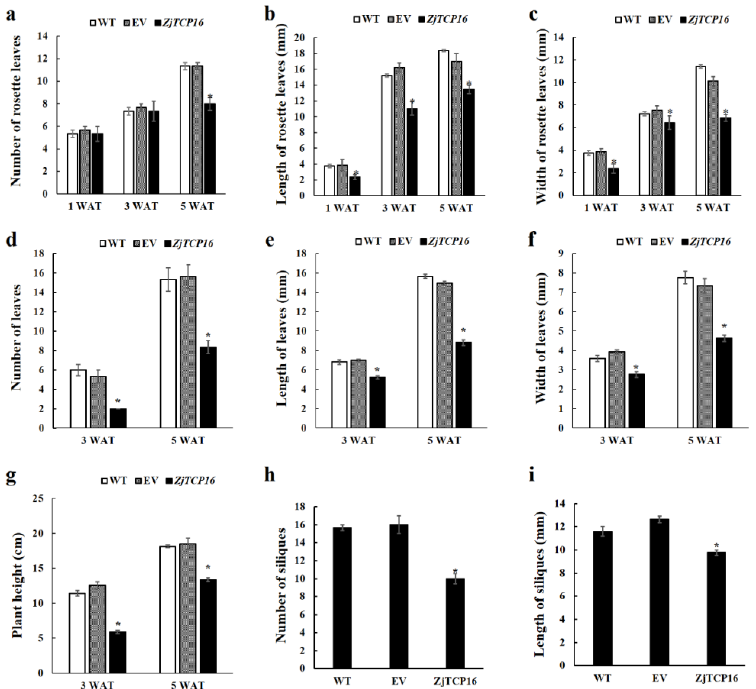
Figure 4. Growth indices of the Arabidopsis overexpressing ZjTCP16 . Bars represent the mean ± standard deviation of 9 plants. Asterisks indicated with WT (* = p < 0.05; one-way analysis of variance (ANOVA)) showed significant differences. ( a ): Average of rosette leaves number of WT, EV and ZjTCP16 -OE Arabidopsis lines. ( b ): Average length of rosette leaves of WT, EV and ZjTCP16 -OE Arabidopsis lines. ( c ): Average width of rosette leaves of WT, EV and ZjTCP16 -OE Arabidopsis lines. ( d ): Average number of leaves of WT, EV and ZjTCP16 -OE Arabidopsis lines. ( e ): Average length of leaves of WT, EV and ZjTCP16 -OE Arabidopsis lines. ( f ): Average width of leaves of WT, EV and ZjTCP16 -OE Arabidopsis lines. ( g ): Average plant height of WT, EV and ZjTCP16 -OE Arabidopsis lines. ( h ): Average number of siliques of WT, EV and ZjTCP16 -OE Arabidopsis lines. ( i ): Average length of siliques of WT, EV and ZjTCP16 -OE Arabidopsis